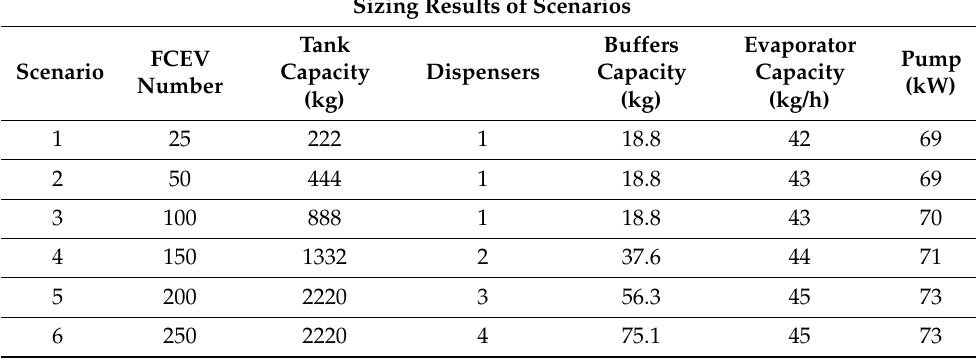
Table 3. Equipment sizing for each